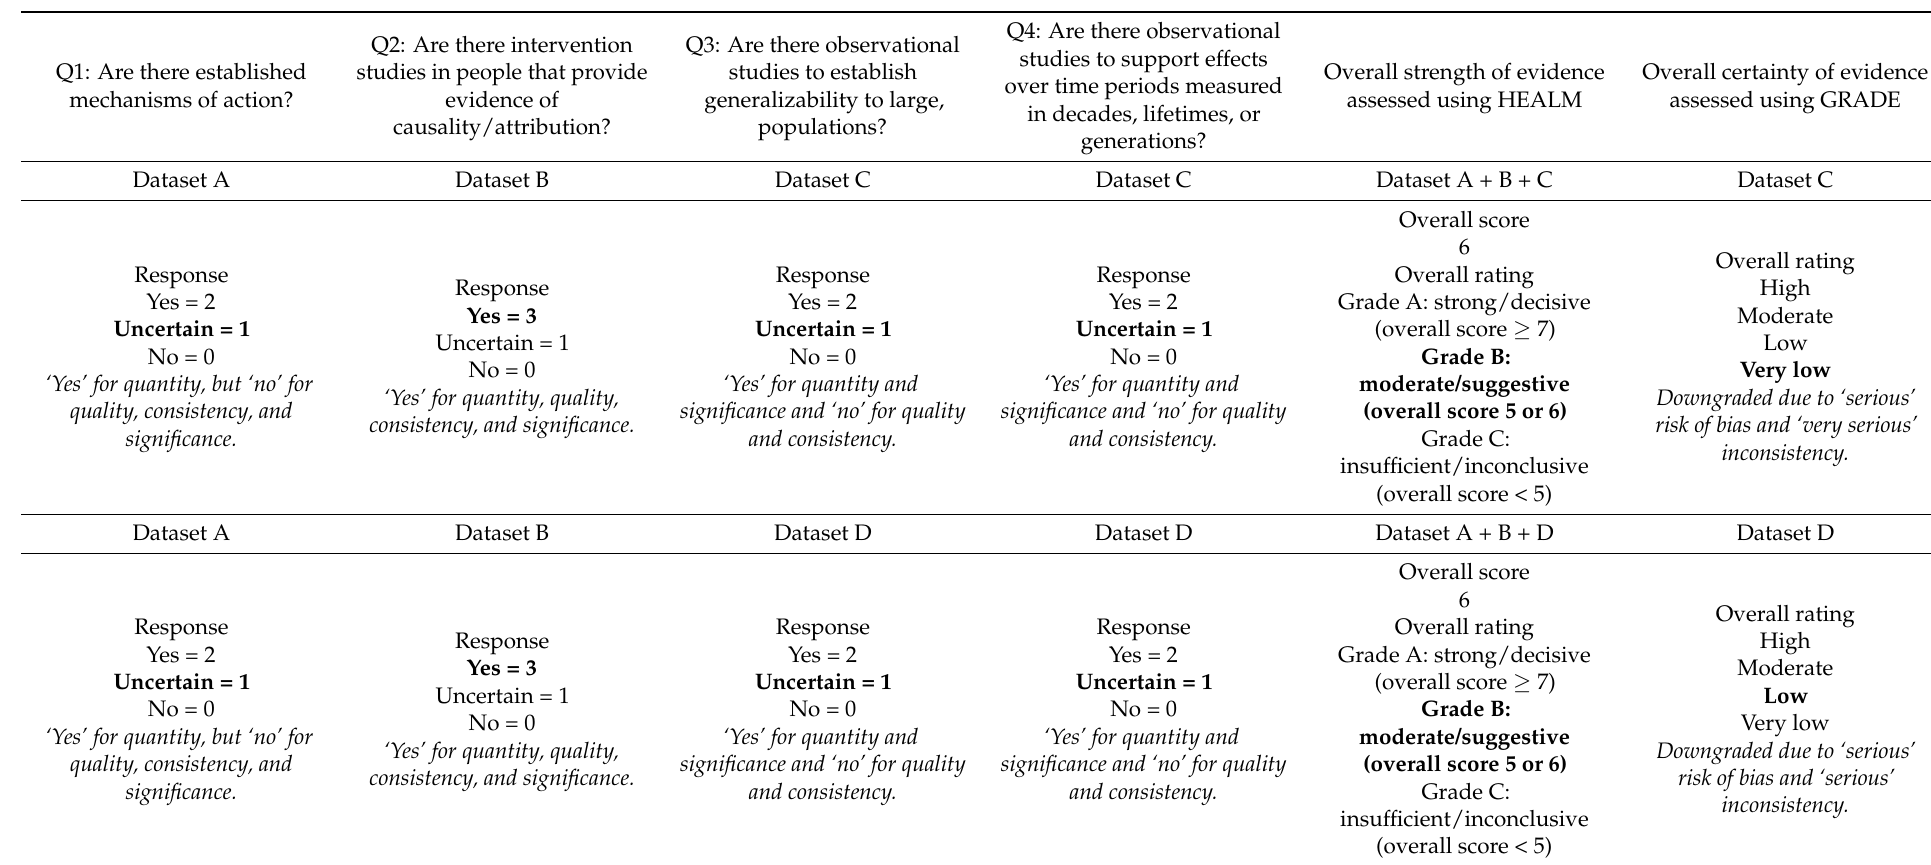
Table 3. Overall strength of evidence assessed using the Hierarchies of Evidence Applied to Lifestyle Medicine (HEALM) approach and comparison to overall certainty of evidence assessing using the Grading of Recommendations, Assessment, Development and Evaluation (GRADE) approach a